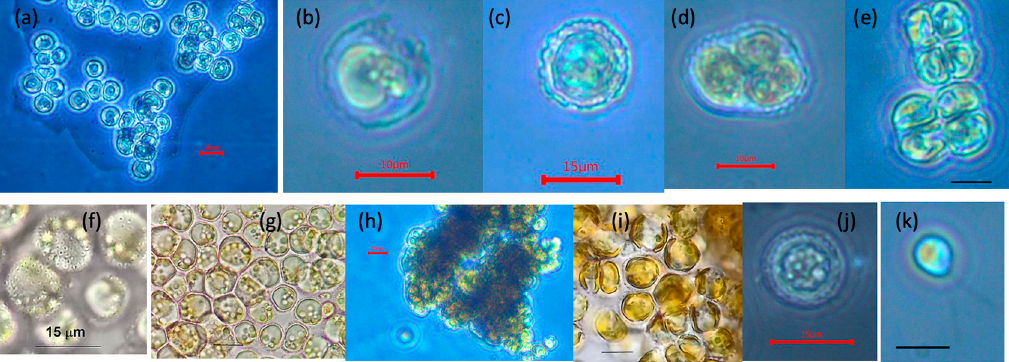
Figure 3. Ochrosphaera neapolitana images from the light microscope: ( a ) light microscope view of non-calcifying cells; scale 10 µm ( b ) a coccolith-bearing cell; scale 10 µm, ( c ) another coccolith-bearing cell; scale 15 µm, ( d ) a divided coccolith-bearing cell; scale 10 µm, ( e ) tetrad (meiocytes) before the reappearance of S-cells; scale 10 µm, ( f ) colony of coccolith-bearing cells under the light microscope; scale 15 µm, ( g ) image showing insides of coccolith-bearing cells; scale 15 µm, ( h ) a colony under the light microscope; scale 10 µm, ( i ) two chloroplasts seen in each cell; scale 10 µm, ( j ) over-calcified pseudocysts; scale 15 µm, and ( k ) a coccolith-bearing flagellated cell; scale 15 µm.